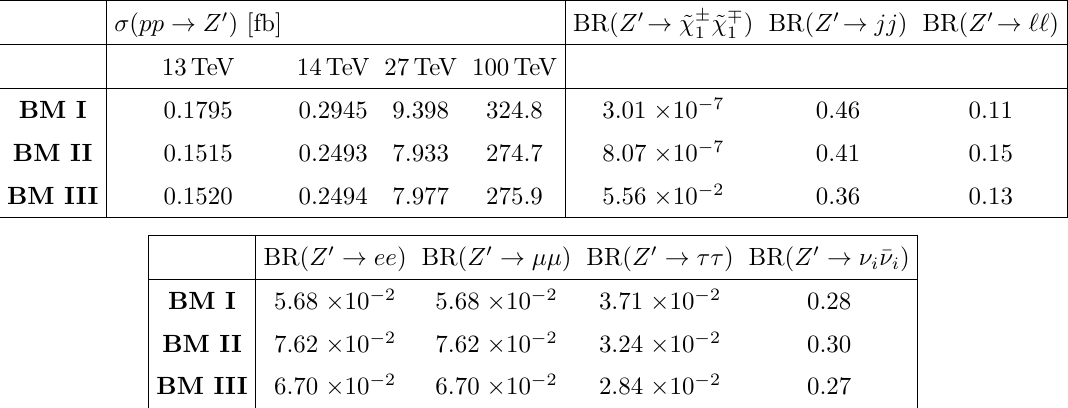
√ s = 13 , 14 , 27 and 100 TeV and branching ratios for the